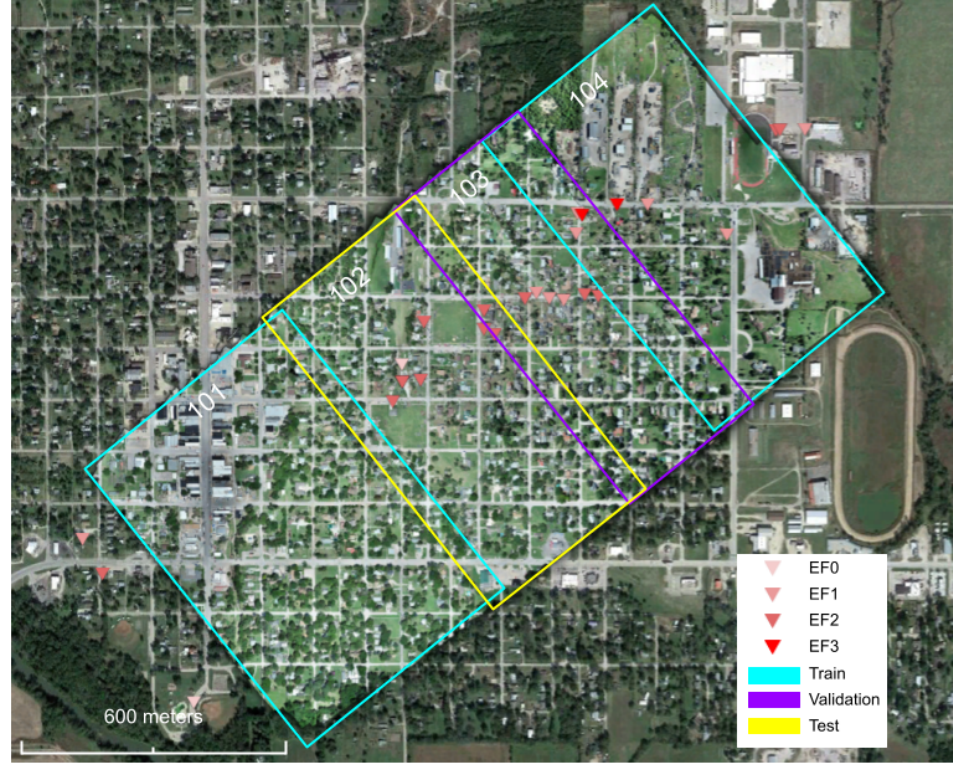
Figure 2. UAS-based orthomosaics were used for training, validating, and testing neural networks. sections 101 and 104 (outlined in cyan) were used for training; section 103 (outlined in magenta) was used for validating; and section 102 (outlined in yellow) was used for